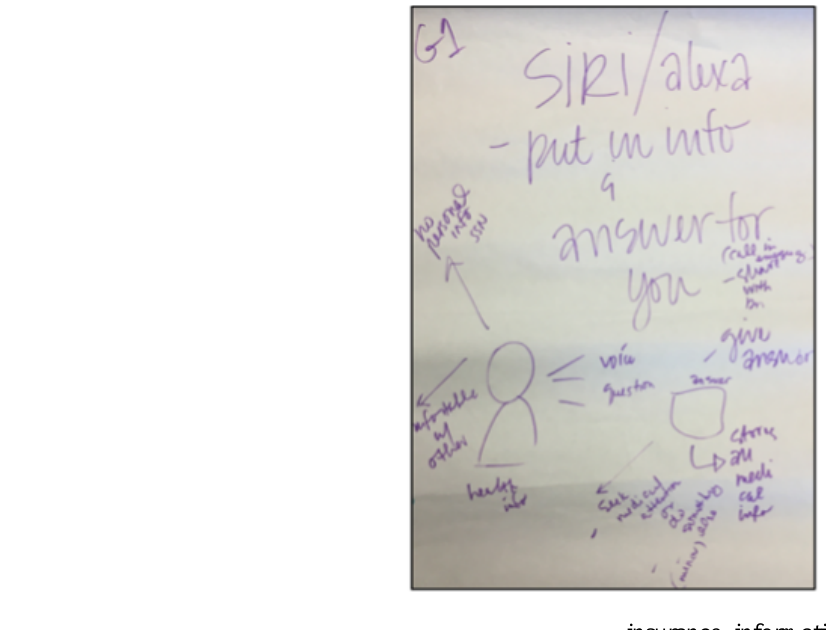
Figure 2. Brainstorming sketch from the design workshop for group